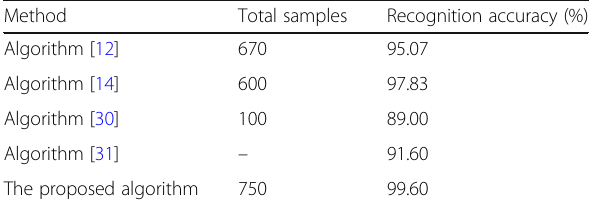
Table 1 HOG features with different parameters Feature types